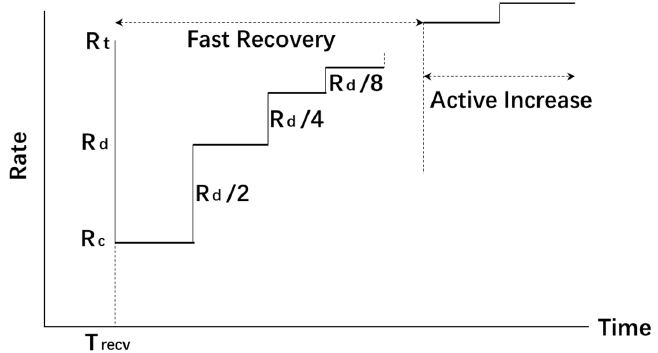
Figure 5. Fast recovery and active increase.